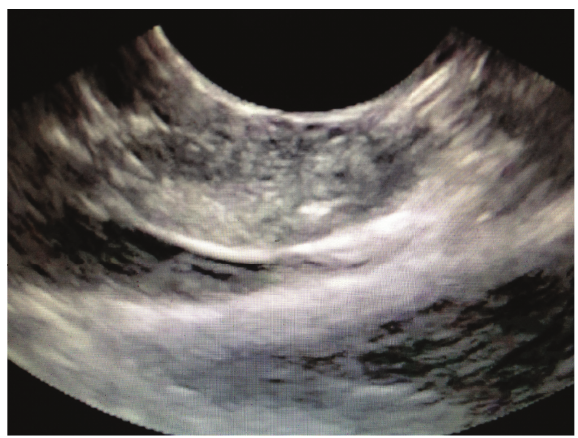
Figure 1: Endoscopic Ultrasound view of the EUS-RFA probe inserted into the porcine pancreas.